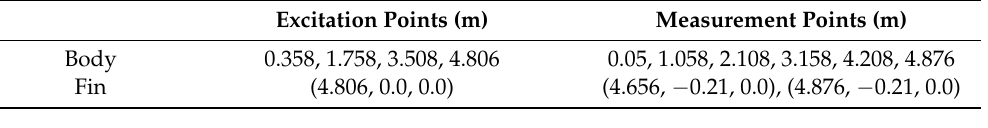
Table 1. Locations of excitation and measurement points.